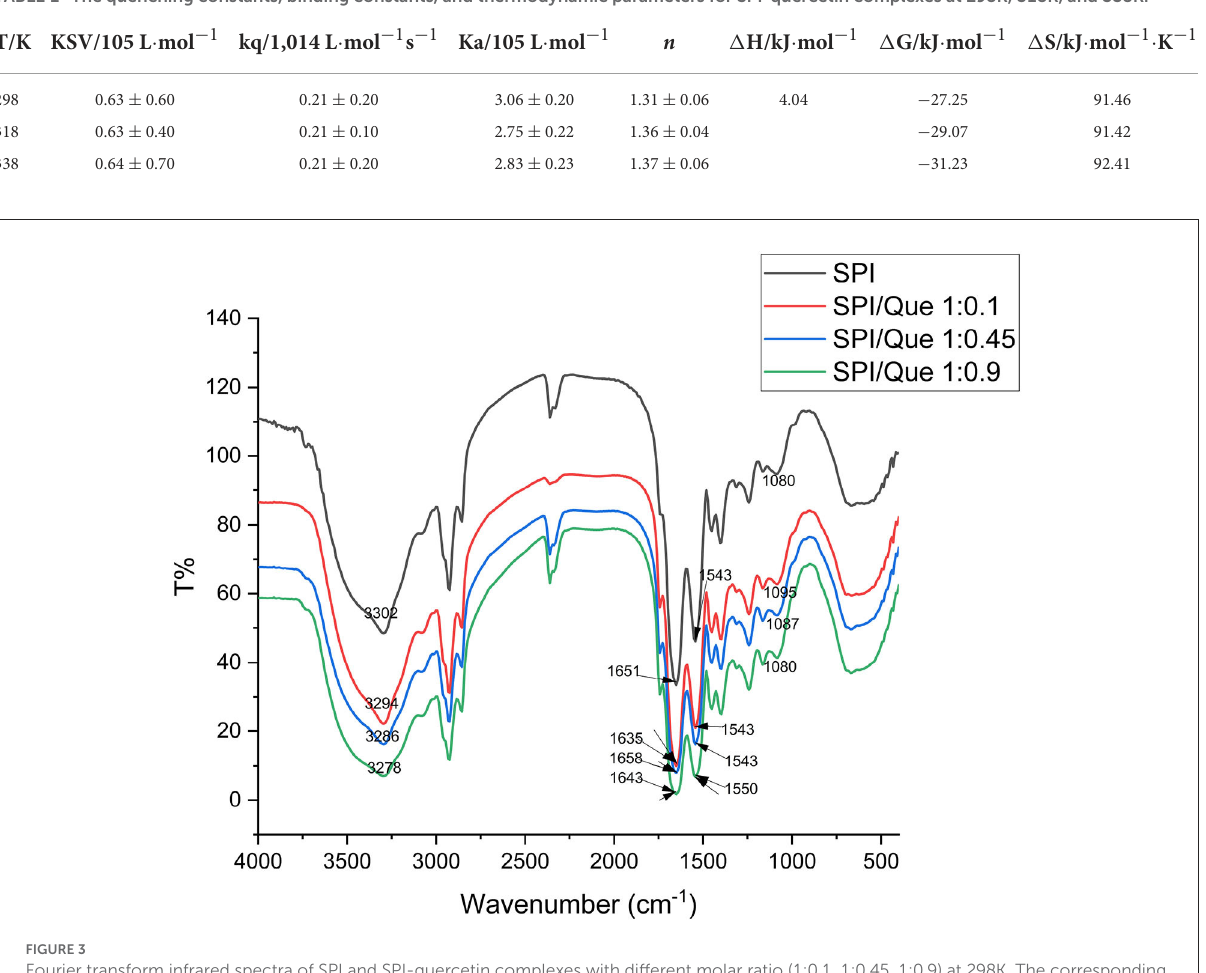
TABLE 1 The quenching constants, binding constants, and thermodynamic parameters for SPI-quercetin complexes at 298K, 318K, and 338K.